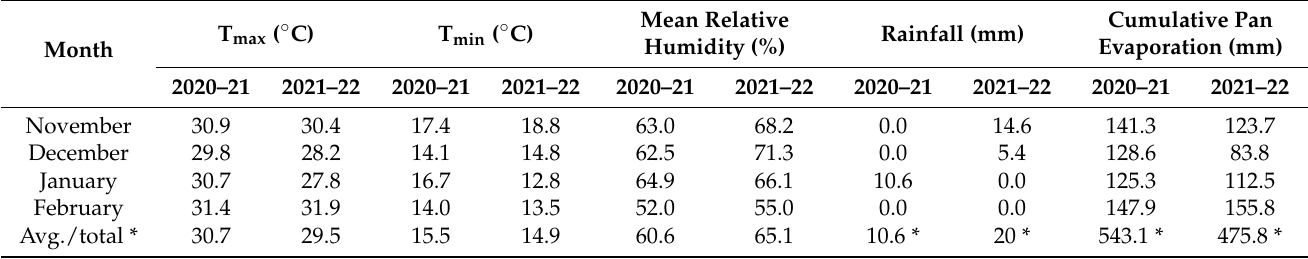
Table 1. Meteorological data of the experimental site during cropping season (2020–21 and